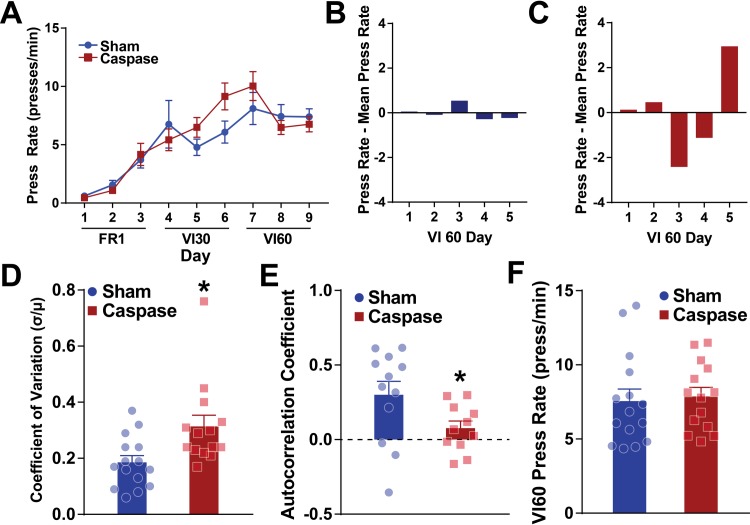
Lesioning striatal patches increases response variability.A. Across CRF (FR1), variable interval 30 (VI30), and variable interval 60 (VI60) training, lesion (red) and non-lesion control (blue) mice have similar increases in press rates. B-C. Representative day-to-day variation of press rates for a control (B) and lesioned (C) mouse. The line at 0 represents the mean press rate across all VI60 days for each respective mouse and bars represent the difference from the mean on each day. D. Coefficient of variation in press rates across VI60 training days is significantly increased in lesioned mice relative to controls. E. Autocorrelation coefficient at lag 1 is reduced in patch lesioned mice relative to controls. F. Press rates across all VI60 days are not different between lesioned and control mice. * indicates p < 0.05.